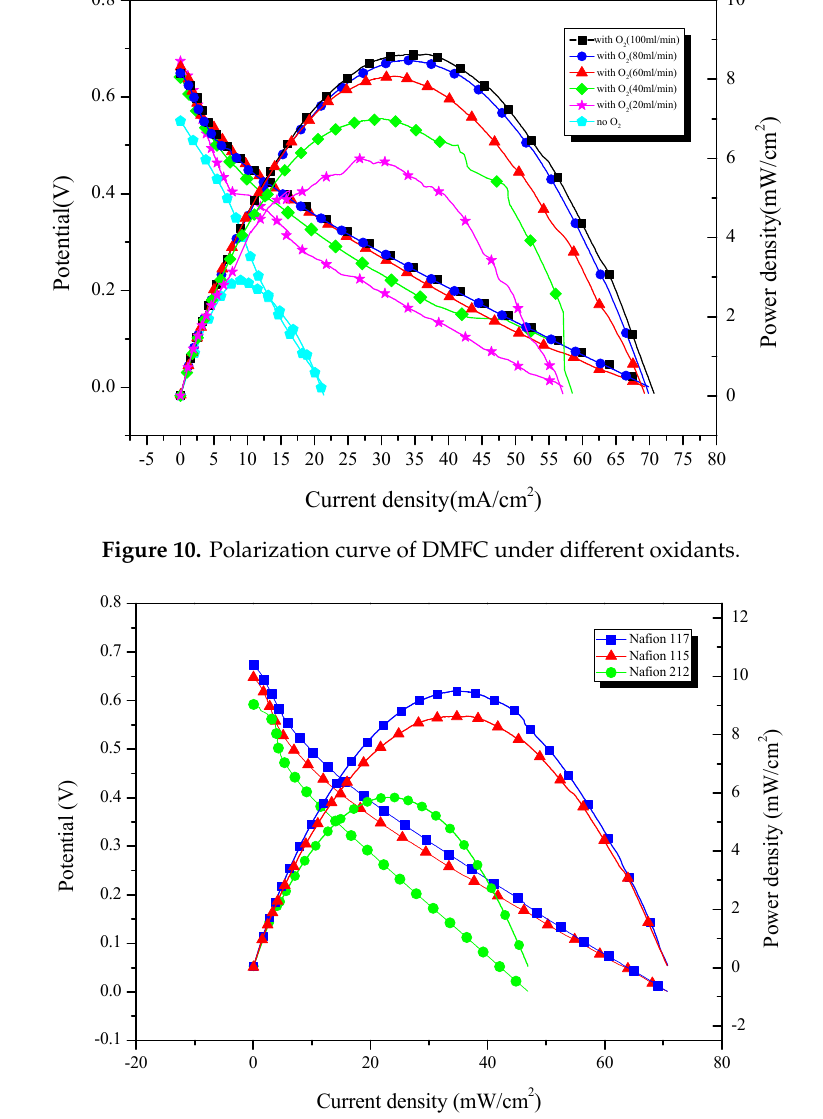
Table 4. Optimal experimental parameters.